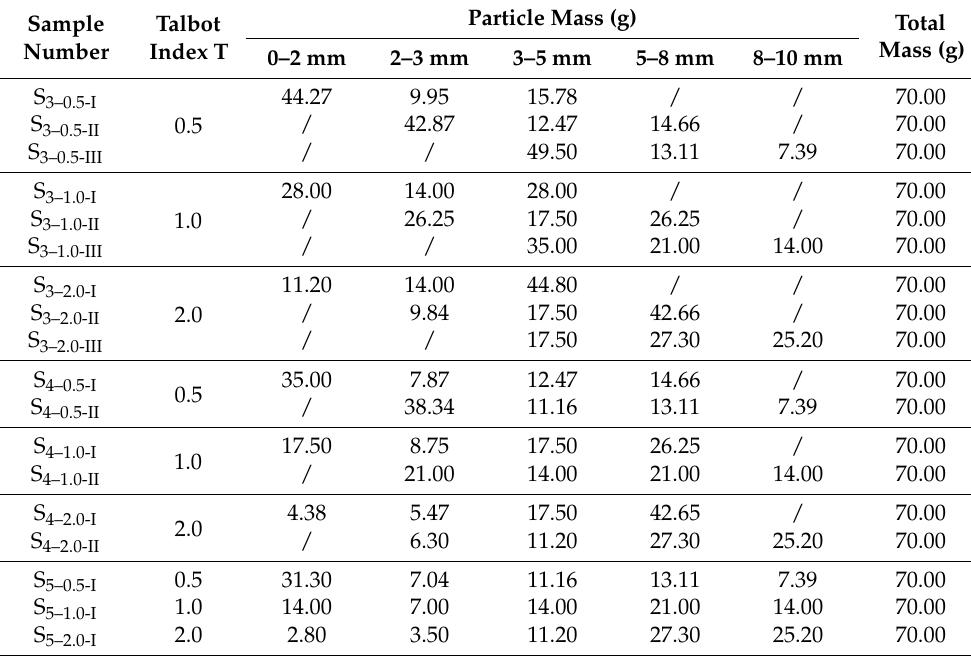
Table 1. Experimental design for different particle size distributions